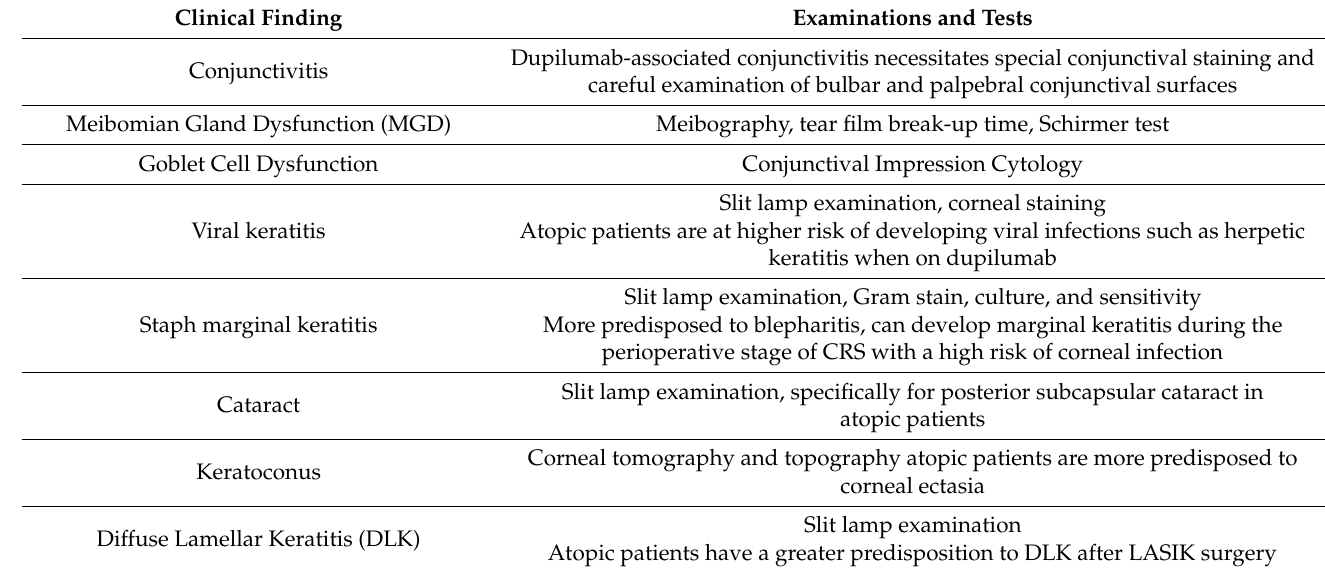
Table 1. Clinical Findings, Eye Examinations and Tests for Evaluation of Atopic Patients on Dupilumab Considering Corneal Refractive